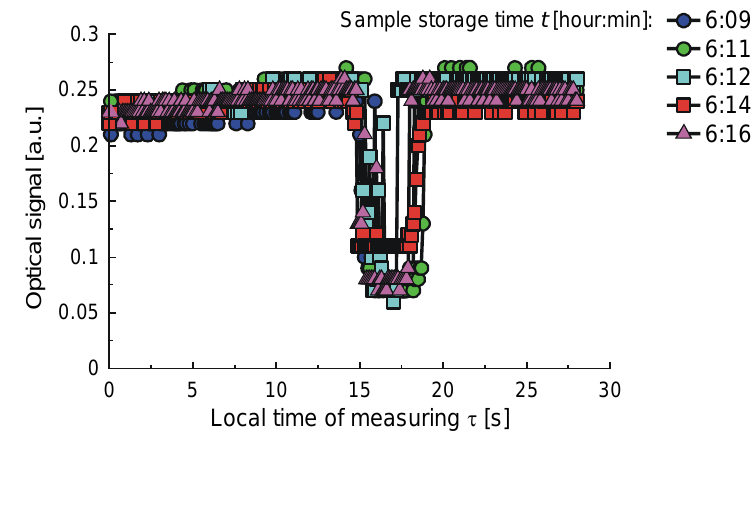
Figure 18. Signals from milk samples stored for about 6